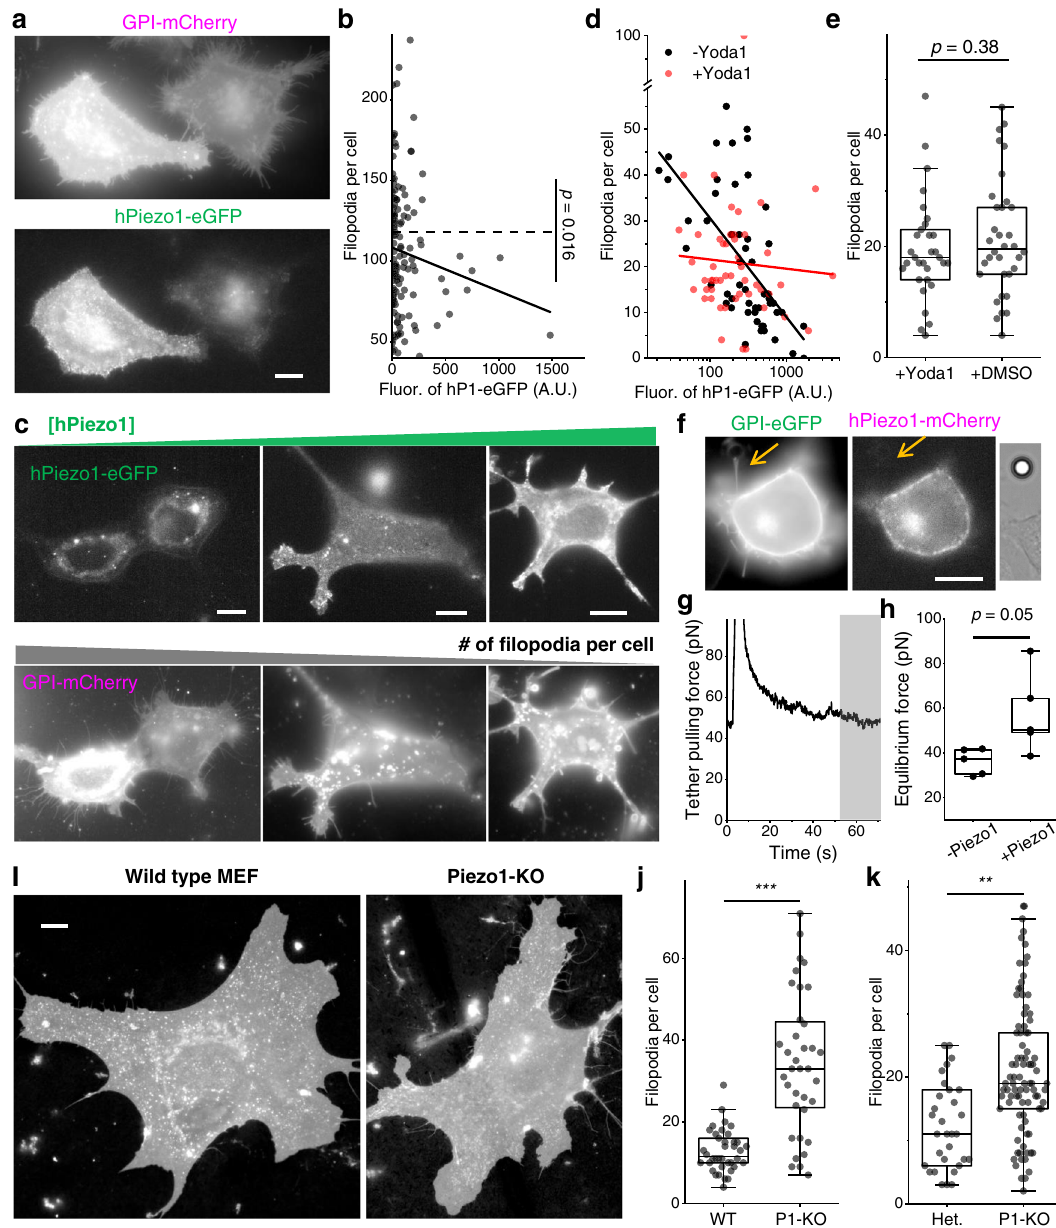
Fig. 5 | Piezo1 inhibits fi lopodia formation. a Fluorescence images of HeLa cells co-expressing GPI-mCherry(up) and hPiezo1-eGFP(down). b Relationbetween the number of fi lopodiaand hPiezo1-eGFPexpressionlevel in HeLa cells ( n =129cells). Dash line: average. Solid line: linear fi t (Pearson ’ s r= − 0.13). c Fluorescence images of HEK293T cells co-expressing hPiezo1-eGFP (up) and GPI-mCherry (down). d Relation between the number of fi lopodia and hPiezo1-eGFP expression level in HEK293T cells cultured in regular (black, n =52 cells) and 5 µ M Yoda1 containing (red, n =50 cells) media. Lines are linear fi ts between y and log(x). Without Yoda1 (black):slope= − 21.5±4.0,Pearson ’ s r= − 0.61. WithYoda1 (red):slope= − 2.0±5.0, Pearson ’ s r= − 0.06. e The number of fi lopodia per Piezo1-KO MEF incubated with 5 µ MYoda1( n =31cells)or0.1%DMSO( n =34cells). f AHEK293Tcellco-expressing hPiezo1-eGFP (left) and GPI-mCherry (middle), with a tether (arrow) pulled by an optically-trapped bead (right). g Timedependent pulling force for the tether in ( f ).